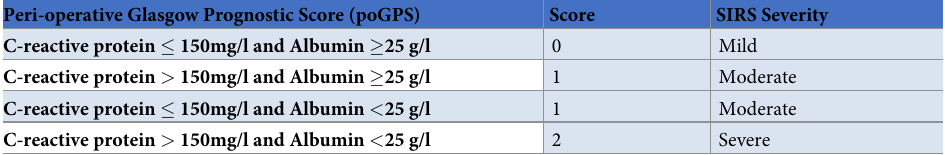
Table 3. Peri-operative Glasgow Prognostic Score